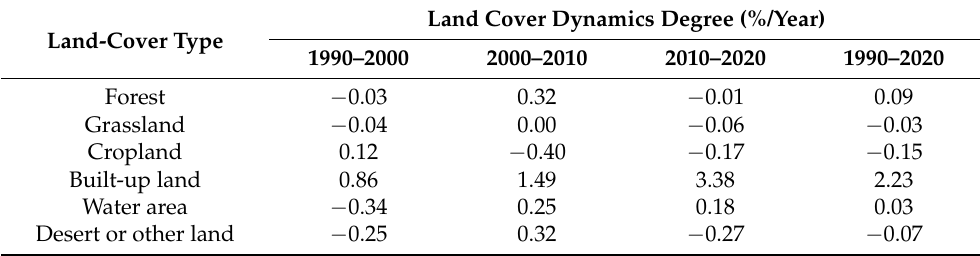
Table 2. Dynamics degree of land cover change in YRB from 1990 to